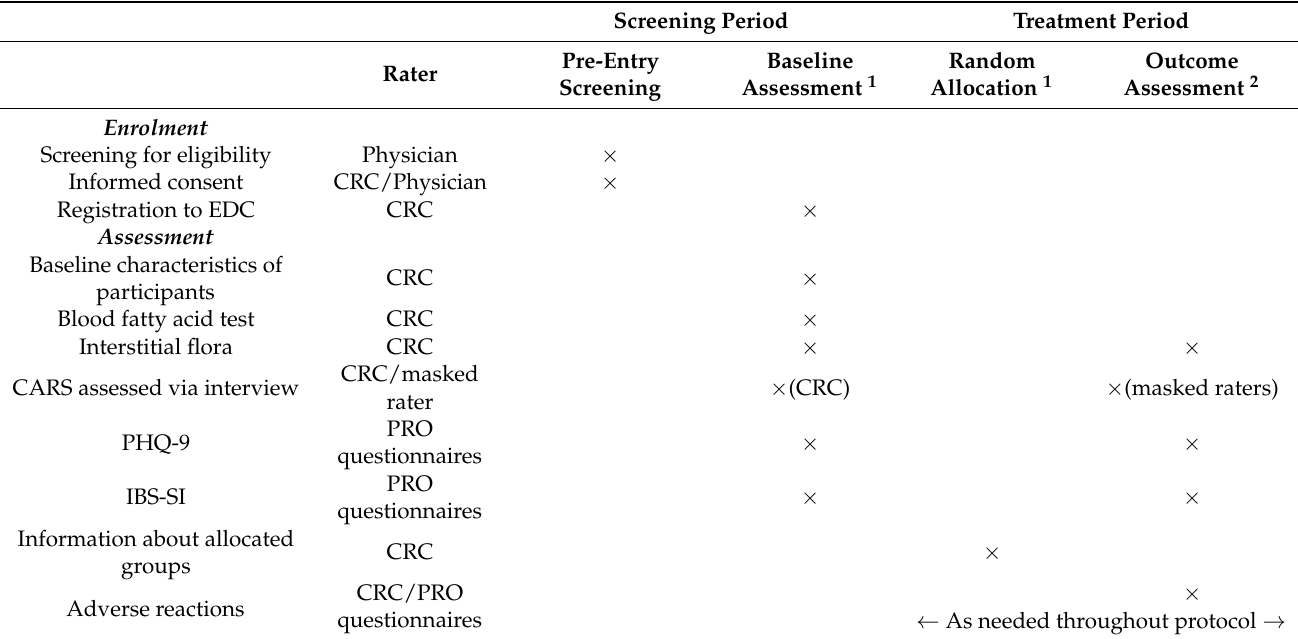
Table 1. Schedule for the